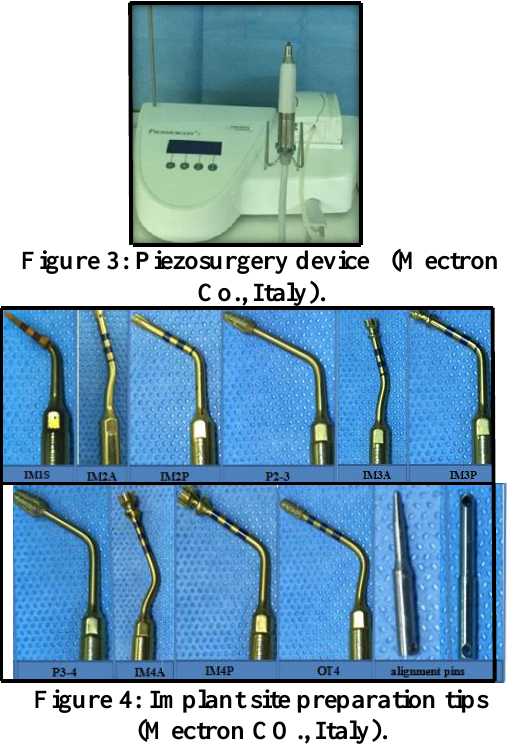
Figure 3: Piezosurgery device (Mectron Co., Italy).